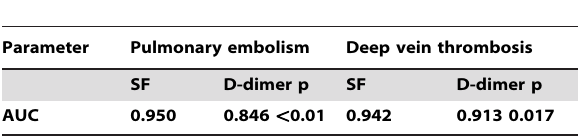
Table 4. Evaluation of the area under the ROC (Receiving Operating Characteristic) curve for SF and D-dimer derived from patients with suspected Pulmonary Embolism or Deep Vein Thrombosis.